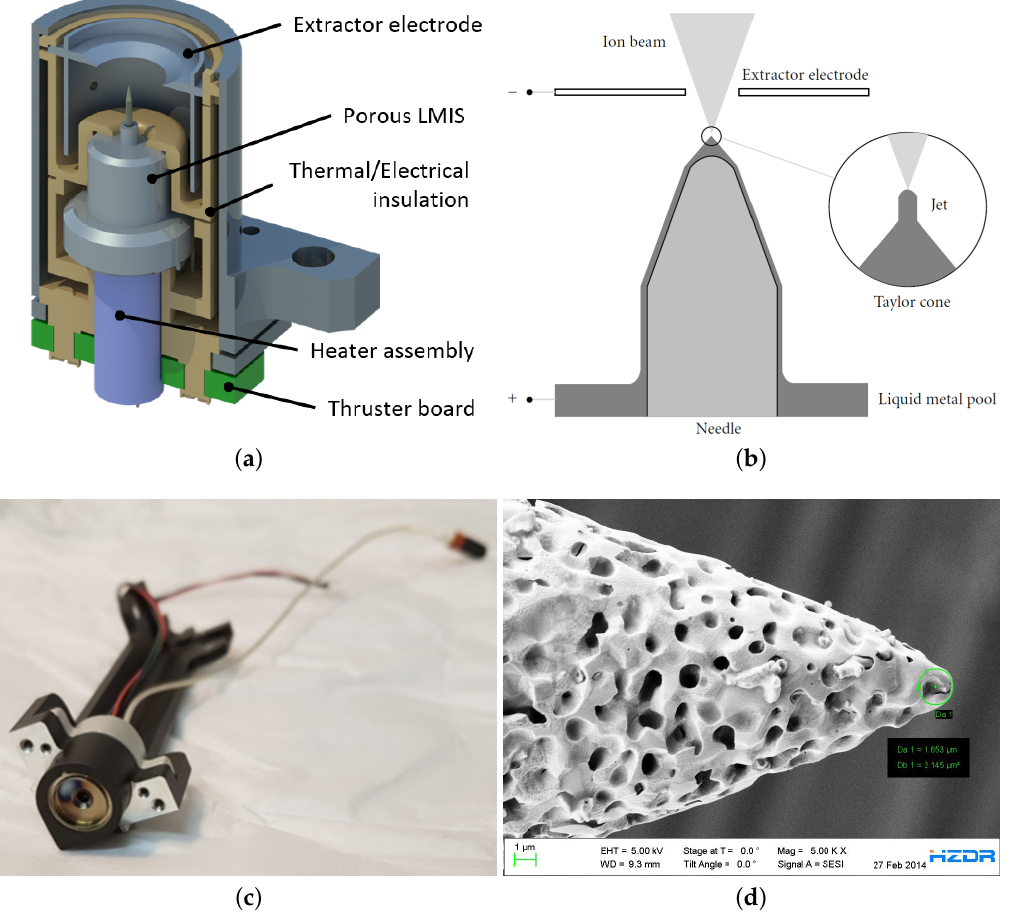
Figure 3. Details of a NanoFEEP thruster head ( a ) CAD model of a cutaway view of a thruster head [12]. ( b ) Working principle of the liquid metal ion source [13]. ( c ) Thruster head integrated into a CubeSat rail. ( d ) Porous tungsten needle with a tip radius of 0.8 µ m